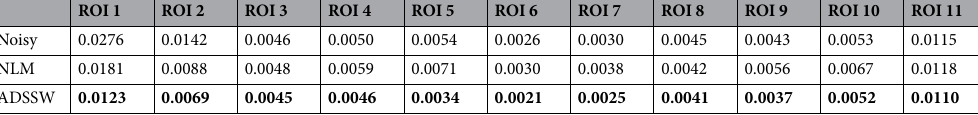
Table 1. The COVs of the representative R2 * values from 9 original noisy datasets with AVG = 1, 2, 4, 8, 16, 32, 64, 128 and 256, and their corresponding NLM- and ADSSW-filtered images. The minimum value in each column is highlighted in bold font.